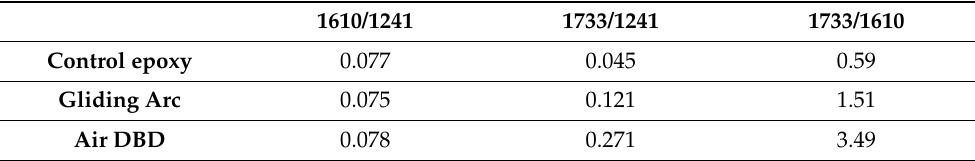
Table 2. Relative peak area for different transmission bands appearing in FTIR spectra for samples measured just after 5 min atmospheric plasma treatment.